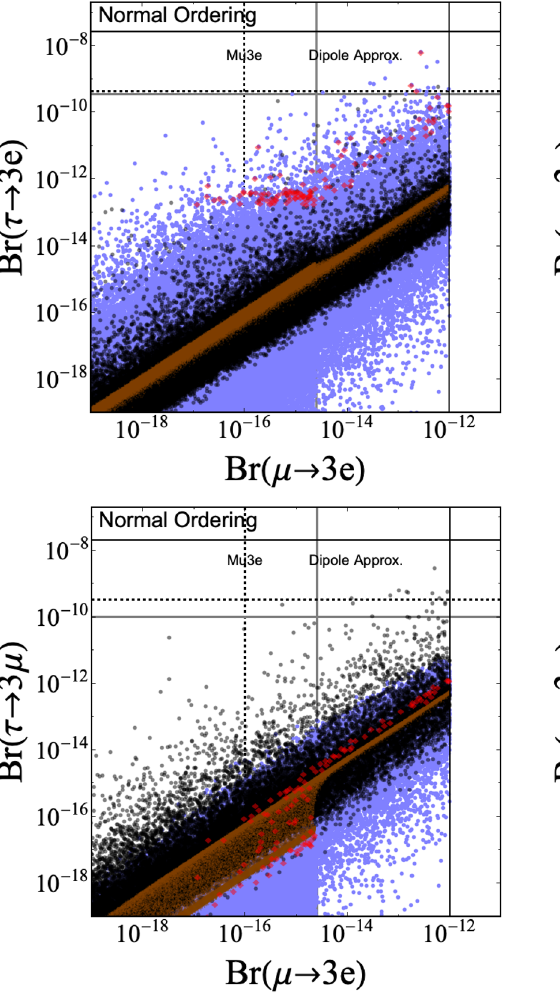
Figure 6 . Branching ratios of tri-lepton decays. The colours are the same as in figure 2. The solid grey lines indicate the respective experimental bounds that would apply to the photon-penguin approximation. Dashed lines indicate prospected experimental